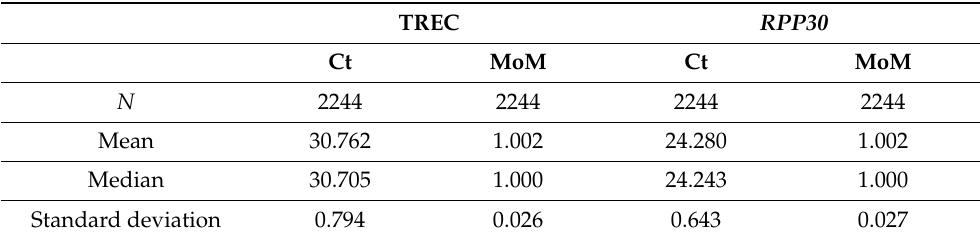
Table 3. Statistics for the cutoff establishment